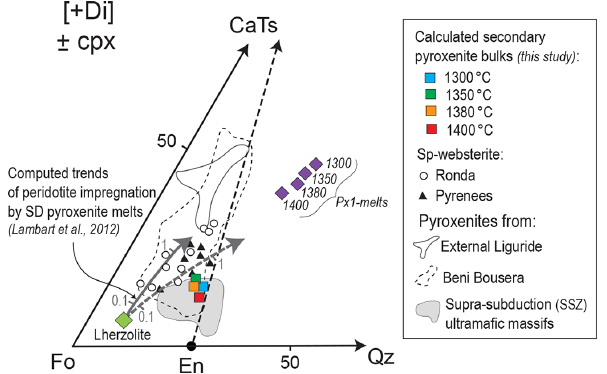
Figure 13. Molar projections from diopside [Di] onto the pseudo- ternary diagram forsterite–calcium-Tschermak–quartz (Fo–CaTs– Qz) (O’Hara, 1972) of computed secondary pyroxenite bulks re- calculated using the mineral compositions in reaction zones from our pyroxenite–peridotite experiments at 2GPa and 1300–1400 ◦ C. Also reported for comparison are data of selected pyroxenites from Ronda (group C; Garrido and Bodinier, 1999; Bodinier et al., 2008), Pyrenees (Bodinier et al., 1987a, b), External Liguride (Borghini et al., 2016), Beni Bousera (Pearson et al., 1993; Kumar et al., 1996; Gysi et al., 2011; Varas-Reus et al., 2018), and supra-subduction ultramafic massifs (data compilation in Eslami et al., 2021). Purple diamonds are the compositions of partial melts from pyroxenite Px1 at 1300–1400 ◦ C (Borghini and Fumagalli, 2020). Grey arrows 1 and 2 are the compositional trends of peridotite impregnation by partial melts from silica-deficient (SD) pyroxenite (M7–16: contin- uous line; M5–40: dashed line) computed for variable melt / rock ratios (from 0.1 to 1) by Lambart et al.